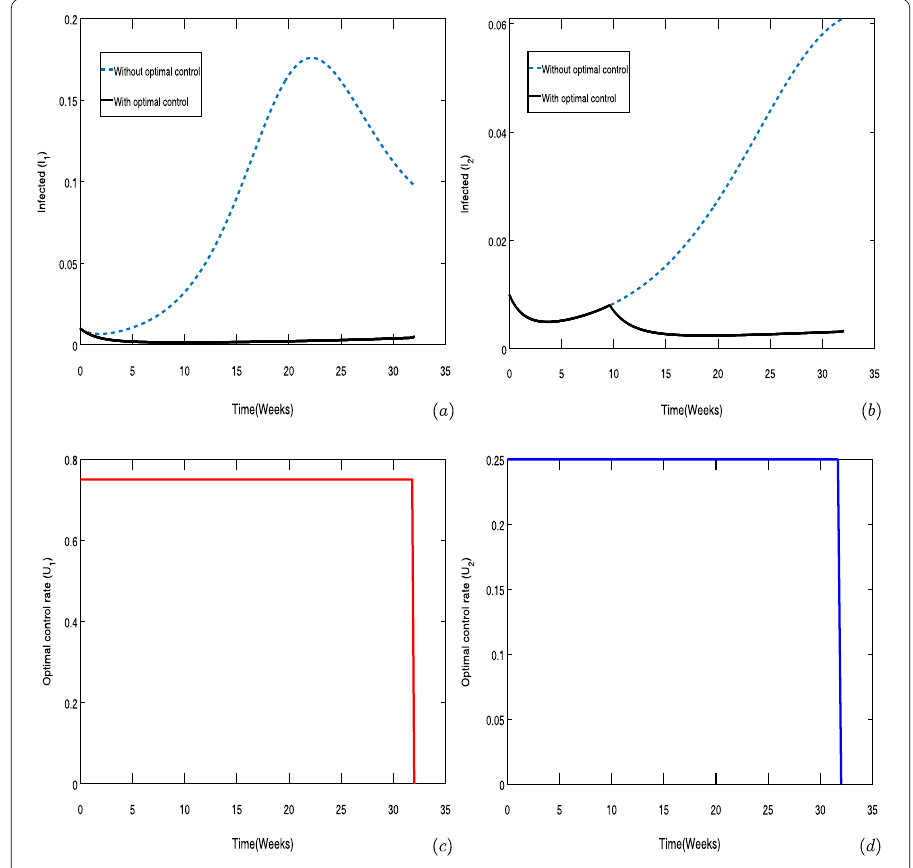
Figure 1 Time series plots showing the effects of optimal control on the ( a ) infected individuals for patch 1 ( I 1 ), ( b ) infected individuals for patch 2 ( I 2 ); also the optimal control graphs for the two controls, ( c ) educational campaigns for patch 1 and ( d ) educational campaigns for patch